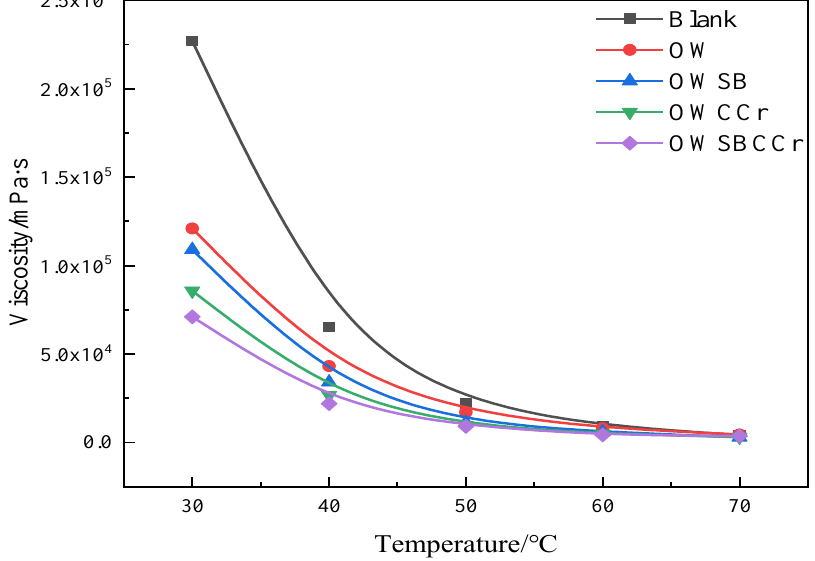
Figure 8. Effect of the ex situ catalyst and in situ bentonite on the reduction in heavy oil viscosity.